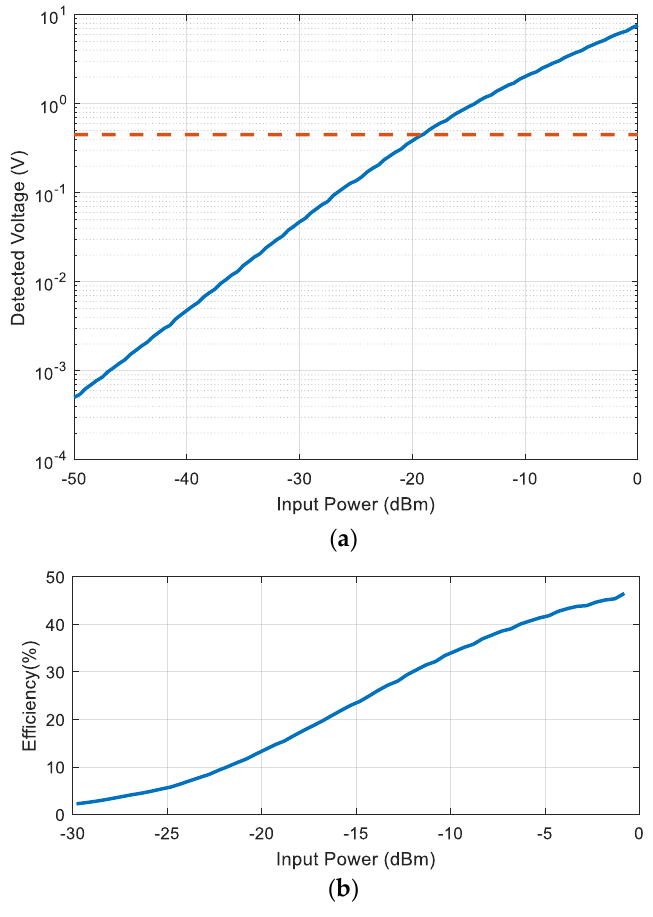
Figure 7. ( a ) Measured detected voltage as a function of input power at 868 MHz. The dashed line shows the minimum voltage needed to power up the oscillator (0.45 V). ( b ) Measured efficiency as a function of the input power at 868 MHz.